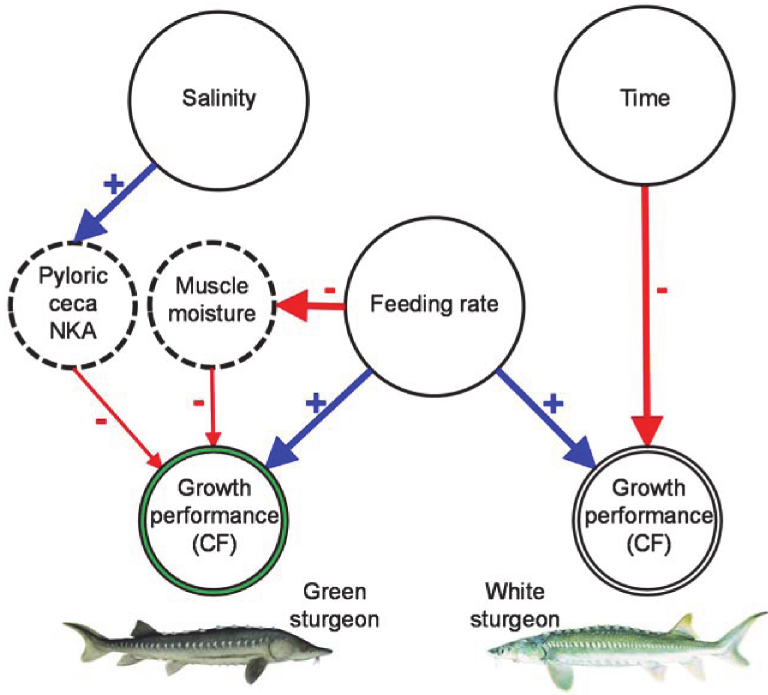
Fig 6. Schematic overview of the primary results. The main relationships among the principal variables identified in this study are summarized as affecting directly or indirectly the growth performance of green and white juvenile sturgeon when challenged with levels of their feeding rate, salinity, and exposure time to salinity. Solid circles: treatments; dashed circles: osmoregulation parameters; double-line circles: growth performance measured by condition factor (CF). The sign associated with each arrow indicates whether the relationship is positive or negative for that effect. Wider arrows refer to the most significant relationships in this